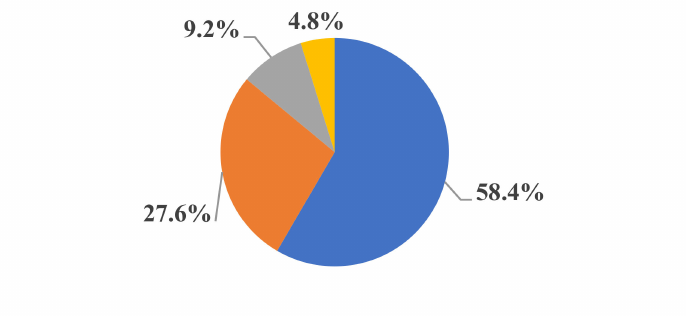
Figure 2. Types of sample matrices extracted by subcritical